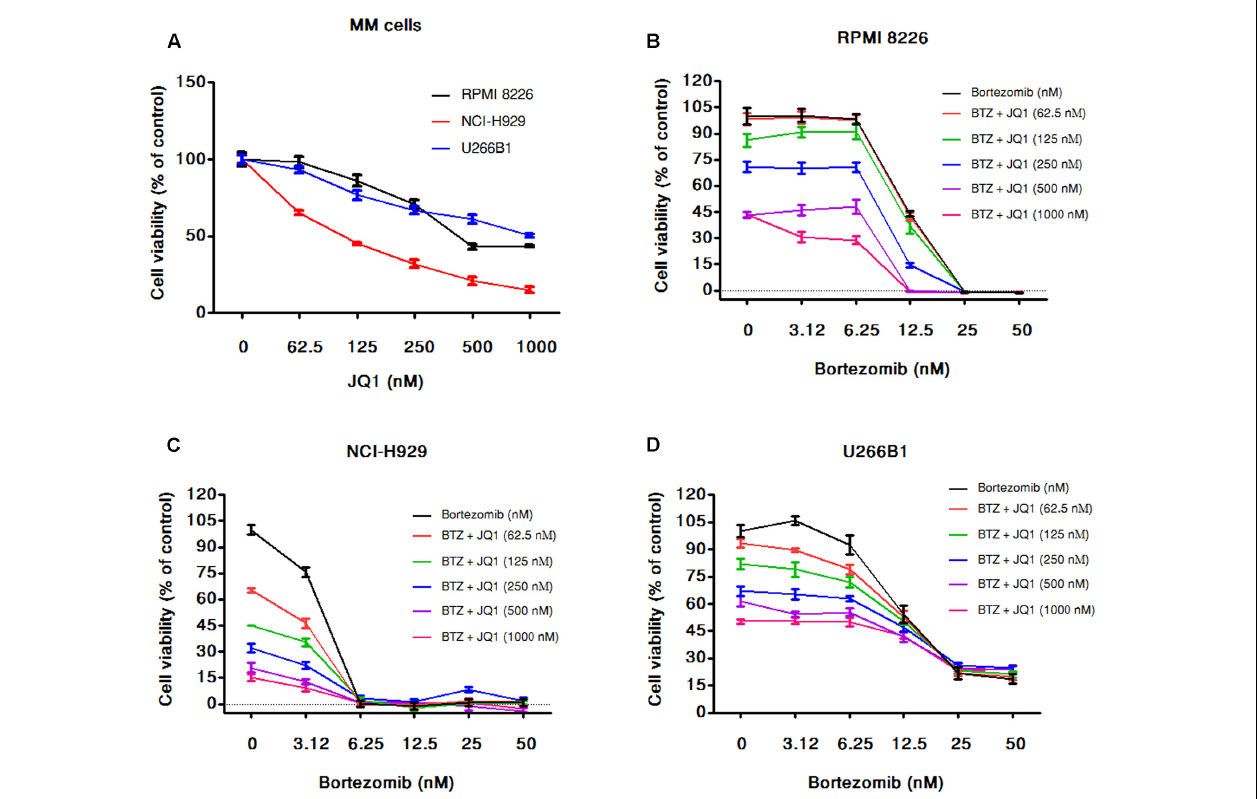
FIGURE 6 | JQ1 enhances cytotoxicity induced by bortezomib in MM cells. (A) The viability of RPMI 8226, NCI-H929, and U266B1 cells after 72 h of JQ1 treatment determined by the alamarBlue R (cid:13) assay as described in Section “Materials and Methods.” The percentage of viable cells normalized to solvent treated control were plotted after background subtraction. Results are as means ± SD ( n = 3). RPMI 8226 (B) , NCI-H929 (C) , and U266B1 (D) cells were incubated with various concentrations of bortezomib (3.125–50 nM) alone and in combination with various concentration of JQ1 (0–1000 nM). After 72 h of the treatments cell viability was assessed by alamarBlue R (cid:13) assay as mentioned above. The percentage of viable cells normalized to solvent treated control cells were plotted after background subtraction. Results are means ± SD ( n =